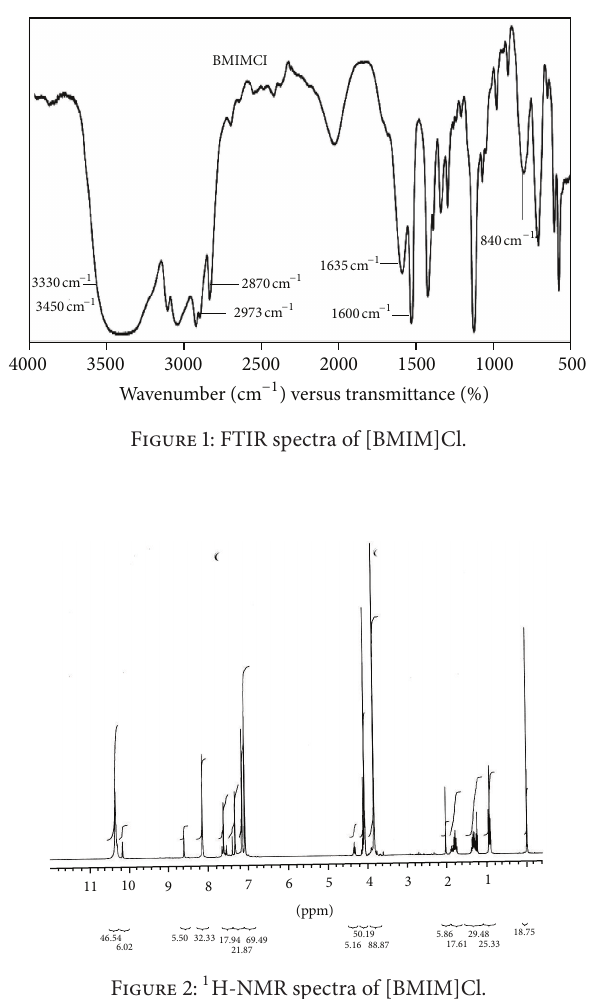
Figure 2: 1 H-NMR spectra of [BMIM]Cl.